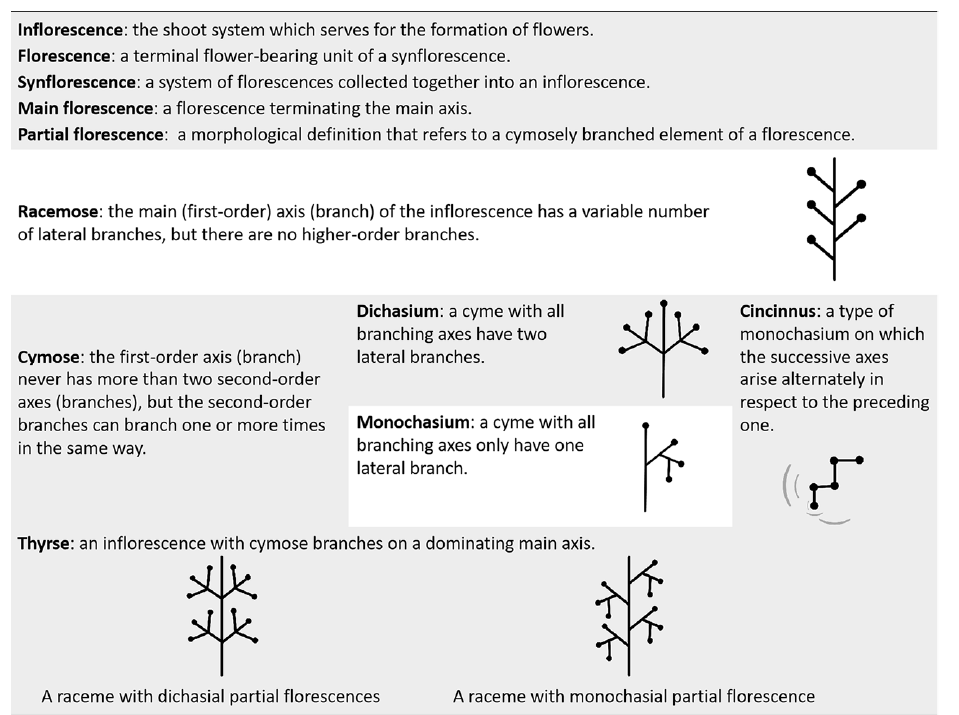
Figure 1. Terminology of inflorescence morphology.